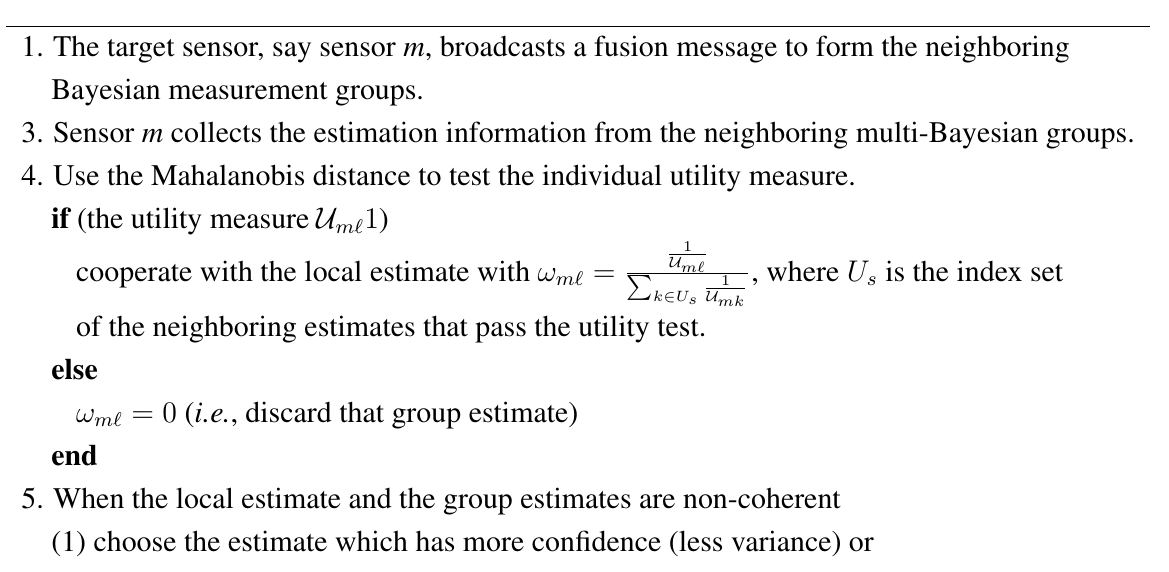
Table 5. The Distributed Estimation